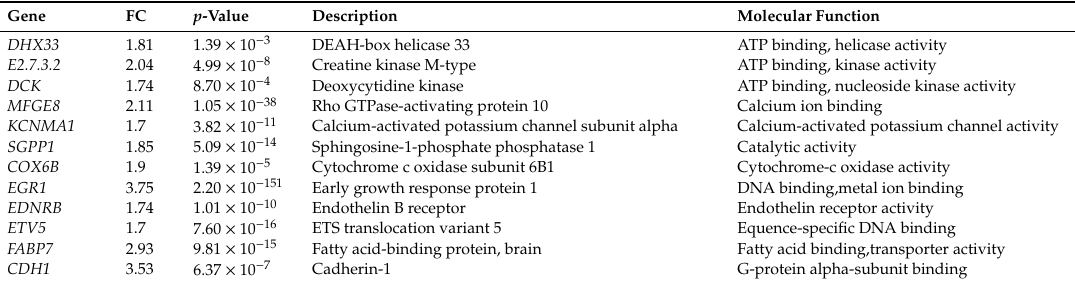
Table 1. Up-regulated genes by epidermal growth factor (EGF) in grass carp pituitary cells. Gene